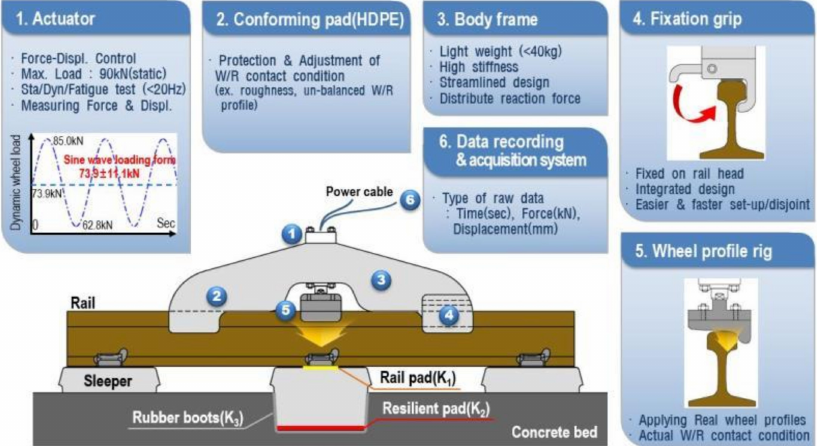
Figure 12. Schematic of track support sti ff ness (TSS) tester